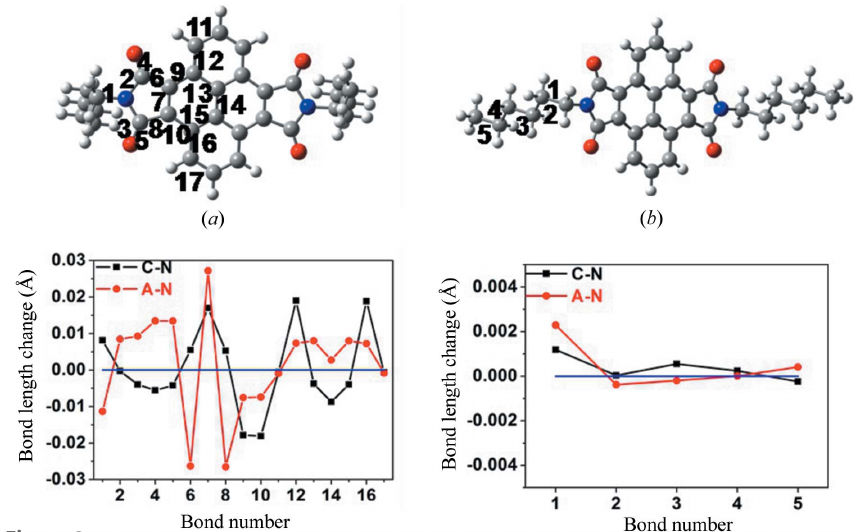
Figure 2 Calculated variations in the bond lengths of isolated C 6 -PyDI upon oxidation (black symbols) and reduction (red symbols), the x axis represents the chemical bond (C—C, C—O and C—N) number that is marked using different numbers.